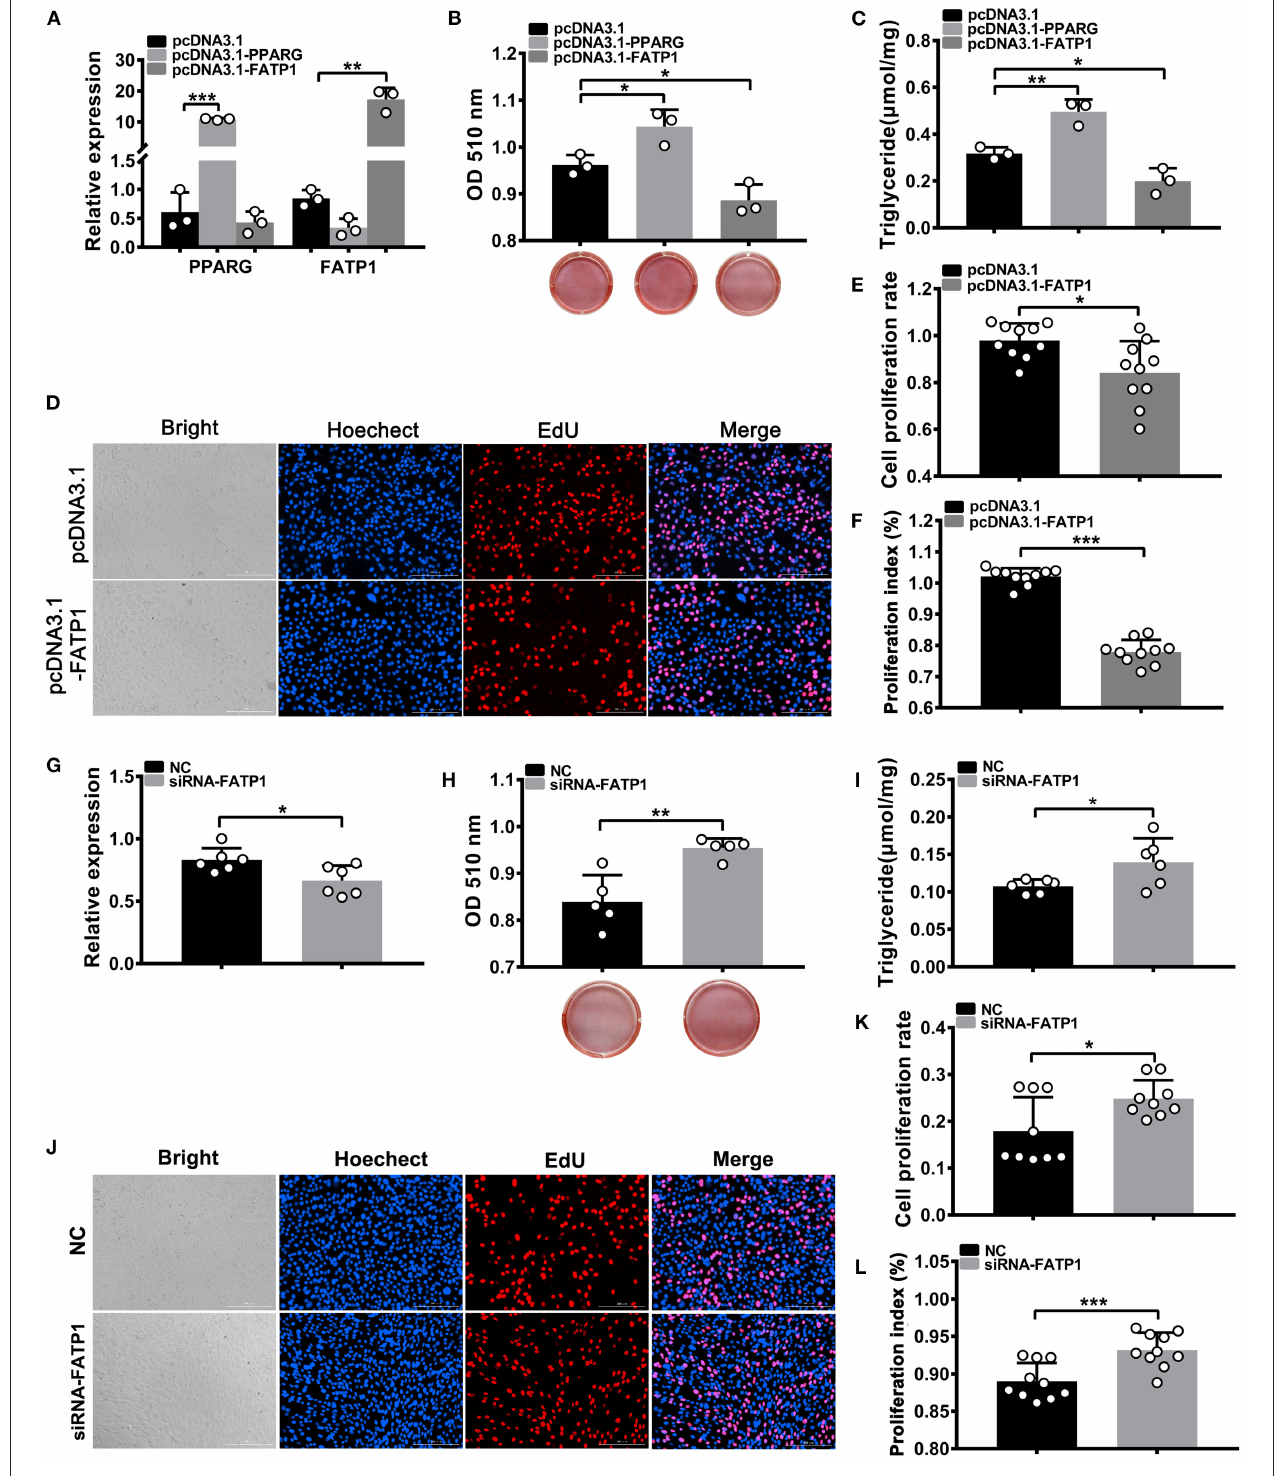
FIGURE 7 | FATP1 inhibits both the proliferation and adipogenic differentiation of 3T3-L1 cells. (A) The overexpression efficiency of PPARG and FATP1 and (G) the interference efficiency in 3T3-L1 cells determined by RT-qPCR. Histogram showing the quantitation of oil red O staining after FATP1 overexpression (B) and FATP1 interference (H) . The triglyceride levels on day 8 of adipogenic differentiation in 3T3-L1 cells after FATP1 overexpression (C) and FATPT interference (I) . Micrographs of EdU assays in 3T3-L1 cells after FATP1 overexpression (D) and FATP1 interference (J) . Scale bar, 200 µ m. Statistical analysis of EdU assays in 3T3-L1 cells after FATP1 overexpression (E) and FATP1 interference (K) . Statistical analysis of CCK-8 assays in 3T3-L1 cells after FATP1 overexpression (F) and FATP1 interference (L) . Data are presented as means ± SD, * p < 0.05, ** p < 0.01, *** p < 0.001.